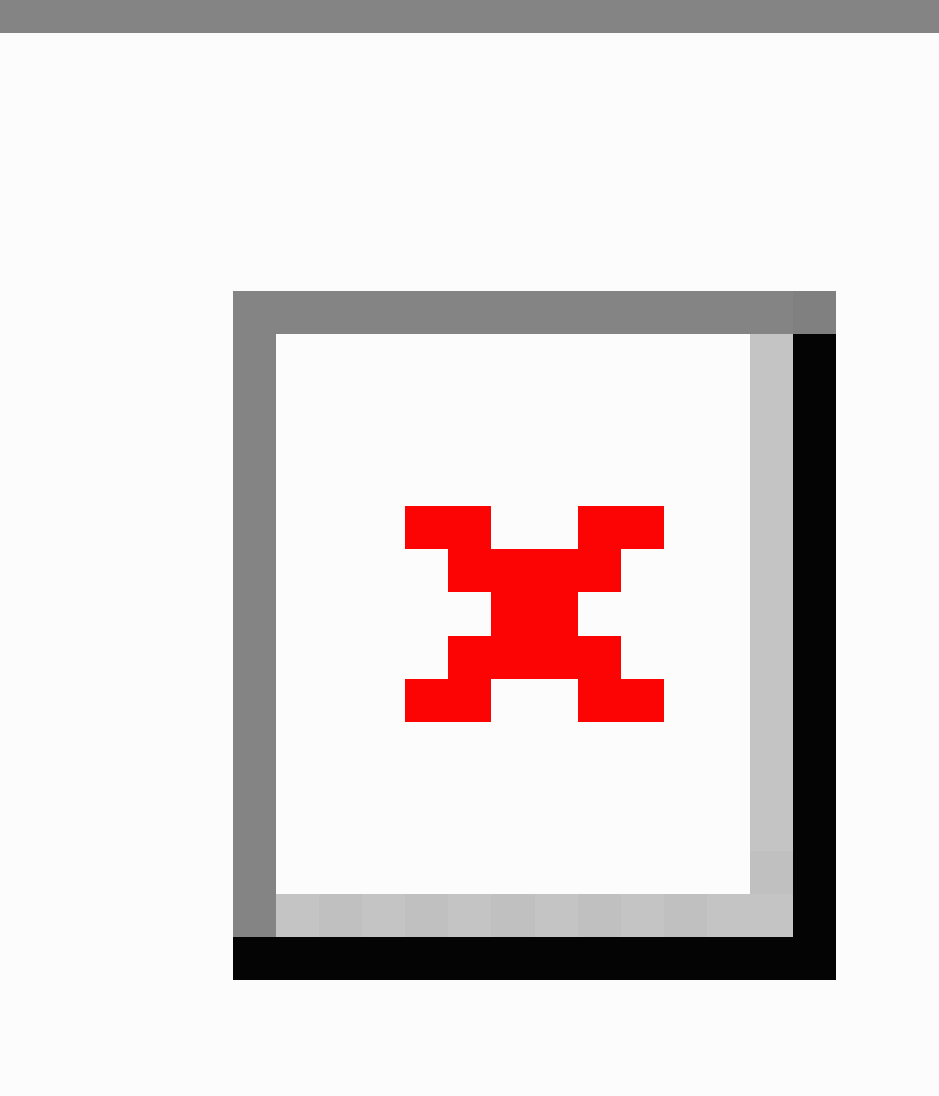
Comparison of the Plateaus by Using the Internet-Based